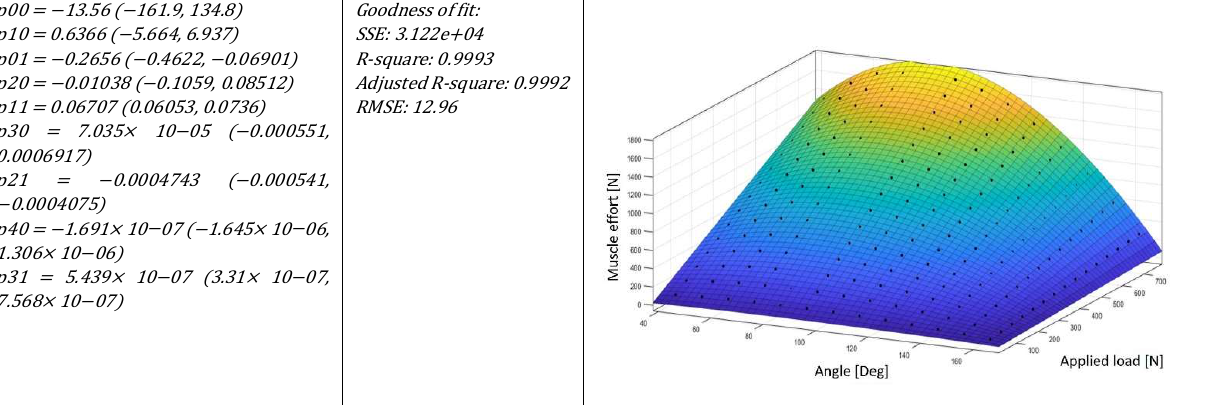
Figure 18. General formulation of long triceps efforts based on wrist load (W) and elbow angle ( α ) and surface reconstruction of the proposed polynomial.